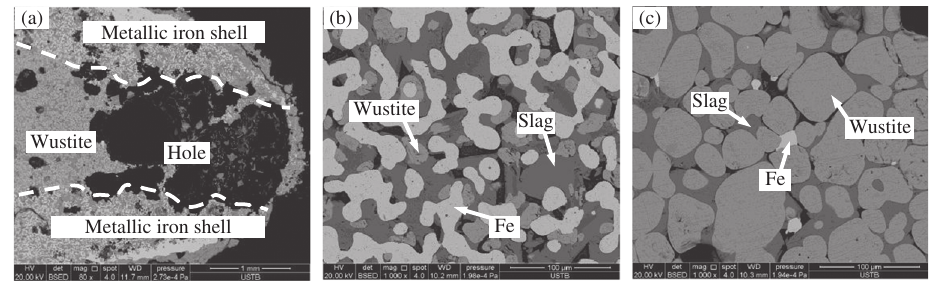
Figure 7: The microstructure of pellet with shrinkage rate at 60% in general